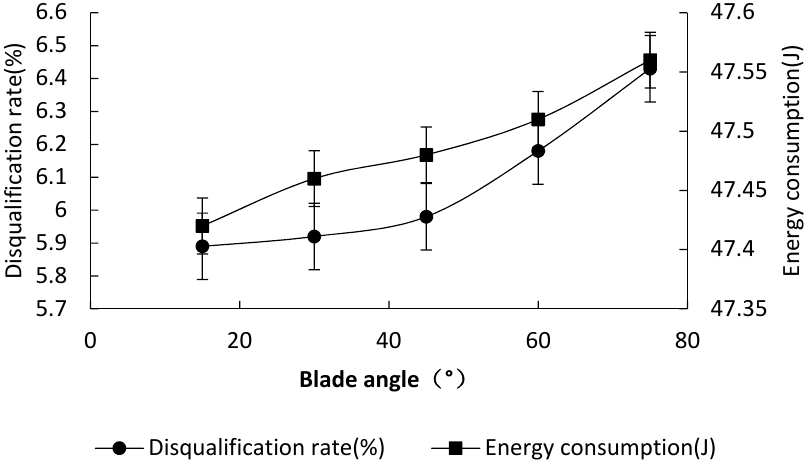
Figure 12. Experimental results of the influence of the cutter edge angle on the qualification rate and energy consumption of straw crushing.